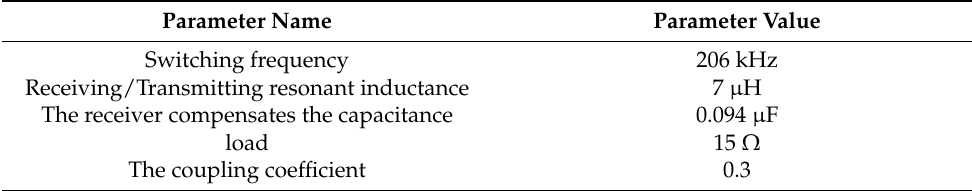
Table 2. Main parameters of the